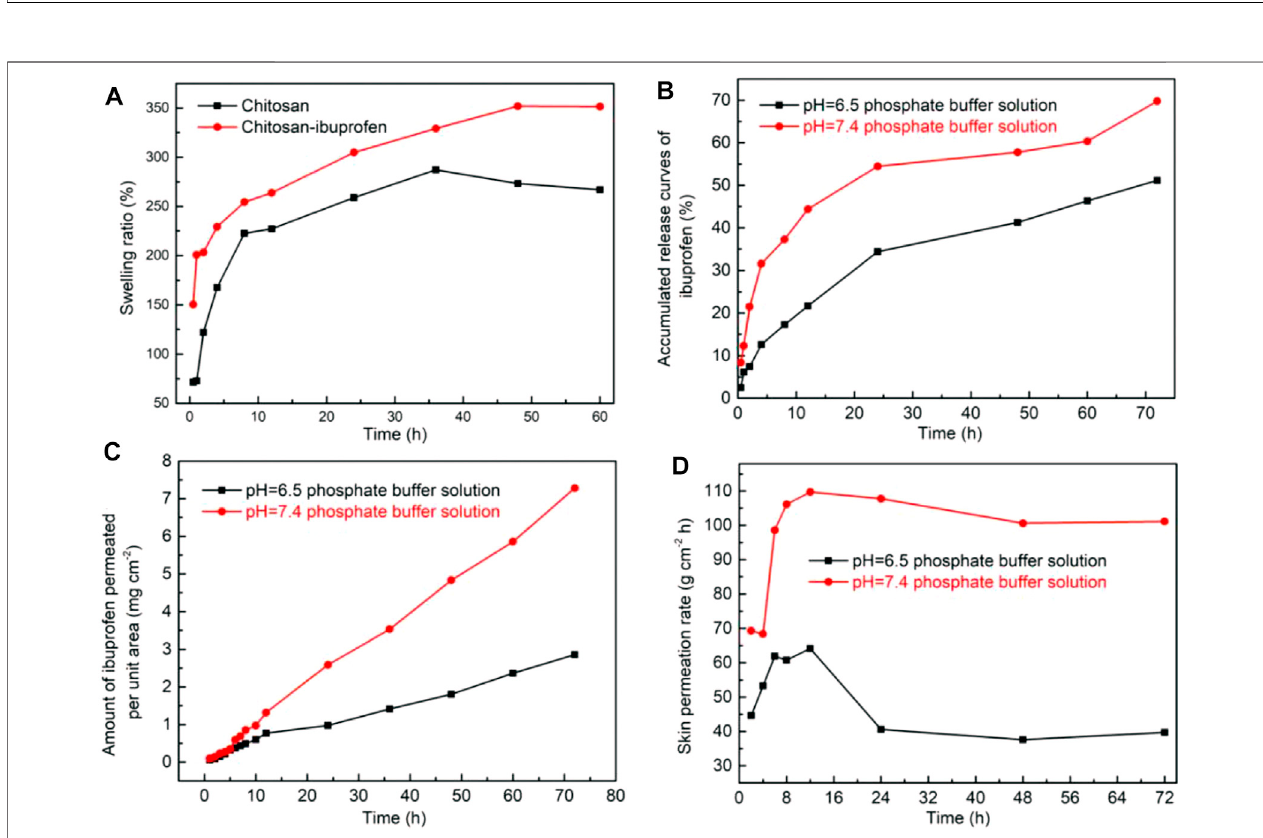
FIGURE 7 | Swelling equilibrium curves of chitosan and chitosan – ibuprofen aerogels (A) ; in vitro release curves of chitosan – ibuprofen aerogels in pH 7.4 and pH 6.5 phosphate buffer solutions (B) ; in vitro release of ibuprofen from chitosan – ibuprofen aerogels through porcine skin (C) ; skin permeation rate of ibuprofen in different pH phosphate buffer solutions (D)